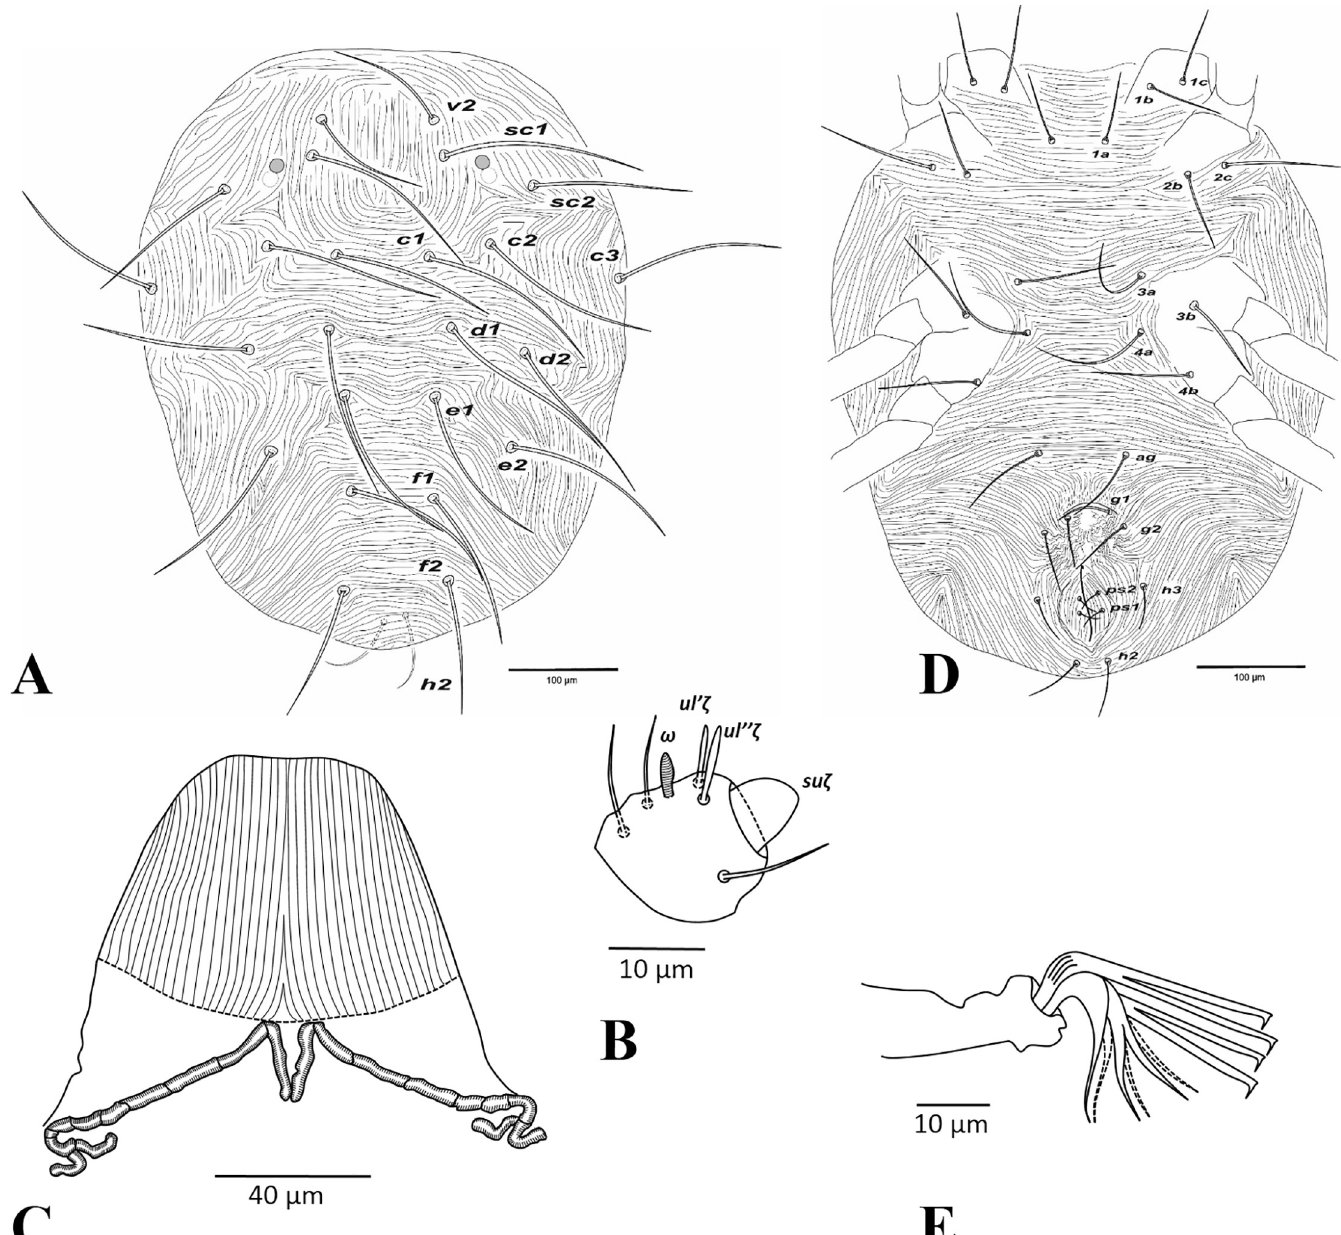
Fig 4. Amphitetranychus savenkoae , female—A. Dorsum, B. Distal segment of palpus, C. Peritremes, D. Venter, E. Empodium of leg I.